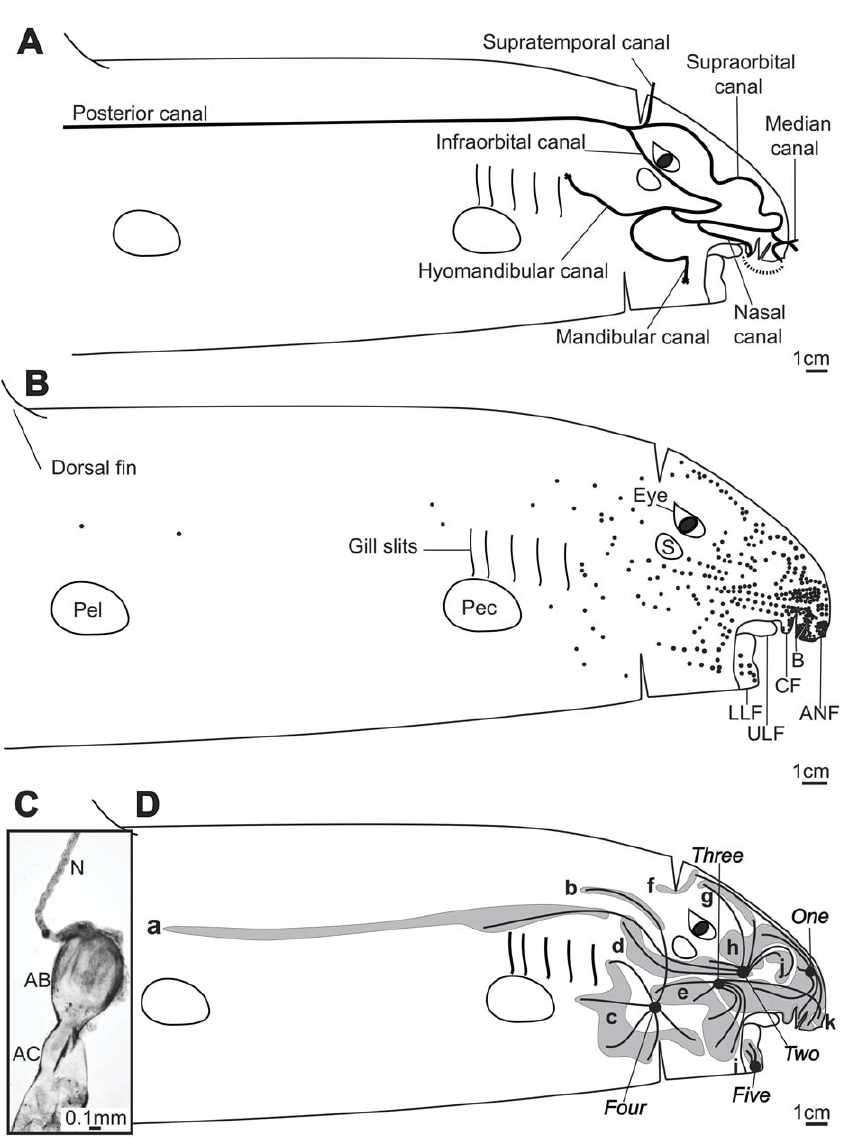
Figure 2. Arrangement of mechanosensory and electrosensory structures in Hemiscyllium ocellatum . A ) Distribution of the mechanosensory lateral line canal. B ) Distribution of electrosensory ampullary pores. Features designated; anterior nasal flap (ANF); barbel (B); circumnarial fold (CF); upper labial furrow (ULF); lower labial furrow (LLF); pectoral fin base (PEC); pelvic fin base (PEL); dorsal fin base (DOR); spiracle (S). C ) Photomicrograph of an ampulla from cluster three , showing its associated ampullary canal (AC), bulb (AB) and nerve (N). D ) Arrangement of ampullary pore fields ( a–k ) and ampullary clusters ( one–five ).